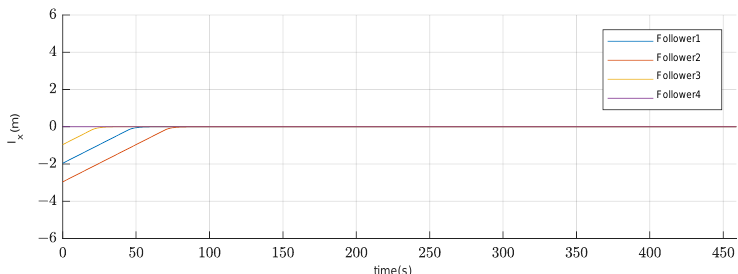
Figure 13. The variation curves of l x for each follower during the movement.